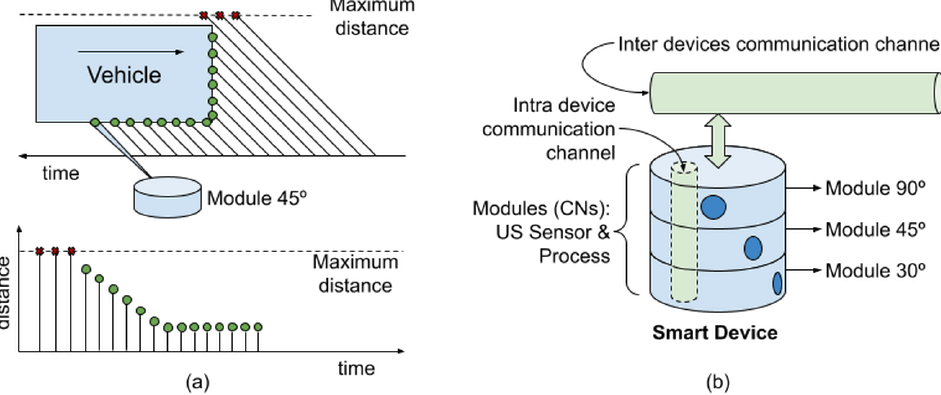
Figure 4. Method to detect the vehicle’s front and side using US rays ( a ), and the device implemented with US modules ( b ).